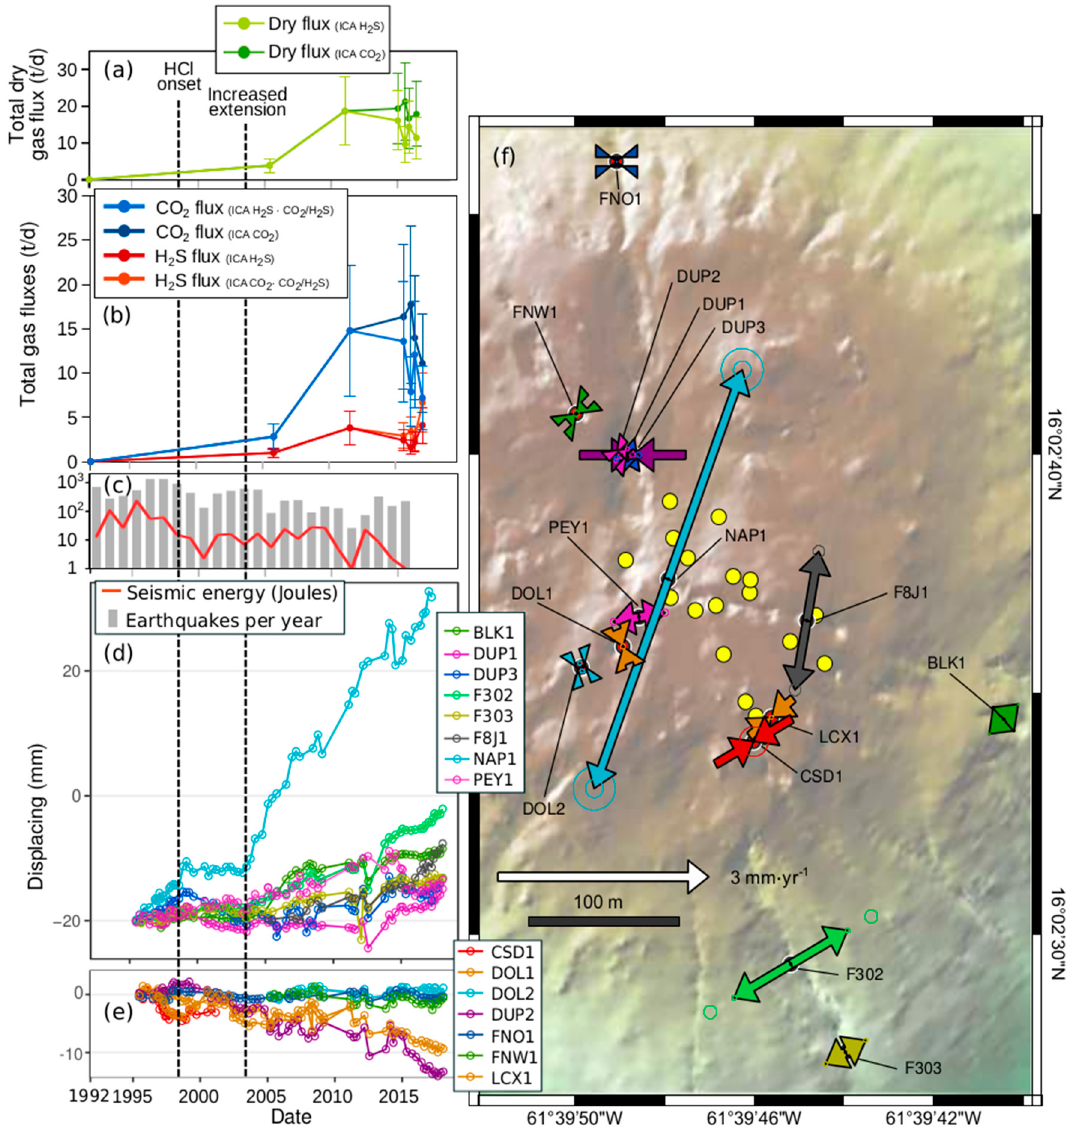
Figure 6. Compared temporal variations of fumarolic gas fluxes, seismicity and dome’s fault extensometry at La Soufri è re between 1992 and 2017. ( a ) Total dry gas flux and ( b ) and H 2 S and CO 2 fluxes calculated from both H 2 S and CO 2 ICAs (for 2006 and 2012 we used only H 2 S ICA-derived values). ( c ) Seismicity and ( d , e ) extent of opening or closing of fractures cross-cutting La soufri è re summit dome revealed by extrensometric survey. ( f ) Vectors and amplitudes of fracture width variations and location of active fumaroles (yellow circles) shown in Figure 1. BLK1: Gou ff re Breislack, DOL1: Fracture Dolomieu Est, DOL2: Fracture Dolomieu Ouest, DUP1: Gou ff re Dupuy Ouest, DUP2: Gou ff re Dupuy Est, F302: Faille du Nord-Ouest, F303: Faille 30 Août Bas, F8J1: Faille 8 Juillet 1976, FNO1: Fente du Nord, FNW1: Faille du Nord-Ouest, LCX1: Fracture Lacroix, NAP1: Crat è re Napol é on, PEY1: Gou ff re Peyssonnel ([28,30], and this